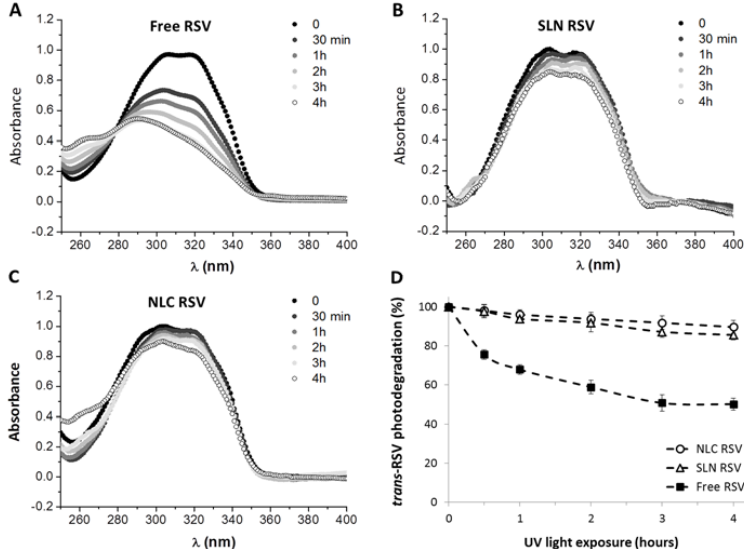
Figure 1. Photostability study of trans -resveratrol exposed to 312 nm UV light for four hours. ( A ) free resveratrol; ( B ) resveratrol loaded in SLNs; ( C ) resveratrol loaded in NLCs; ( D ) Photodegradation profile of trans ‐ resveratrol in aqueous solution ( ■ ) compared to the compound encapsulated in SLNs ( ∆ ) and NLCs ( ○ ).